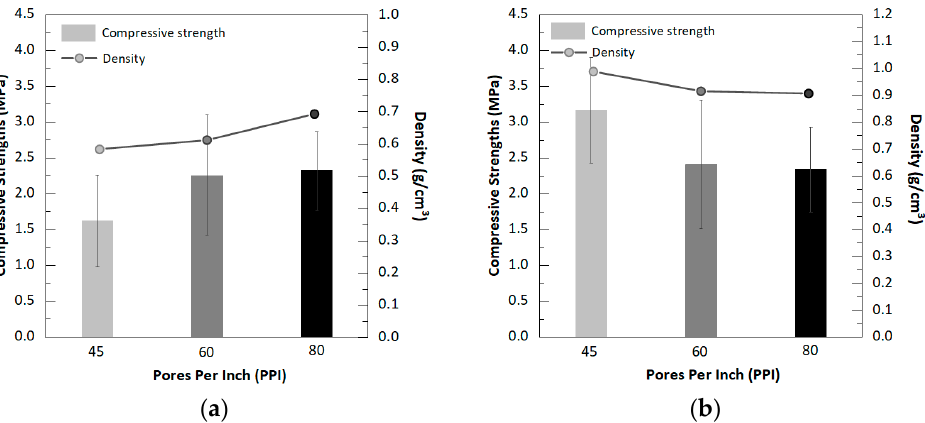
Figure 7. (a) Compressive strengths and densities with pore densities of 45, 60, and 80 PPI with a thickener (using a coarse particle size for the matrix), and (b) compressive strengths and densities with pore densities of 45, 60, and 80 PPI (using a fine particle size for the matrix ). To confirm the effect of the particle size, using coarse alumina as a matrix, zirconia at 40 wt. % and the ZTA slurry with the thickener added were used to control the particle size. The particle size distribution of ZTA according to the ball-milling time is shown in Figure 8a. The particle size is a process variable used to obtain the optimal composition of the reticulated porous ZTA. As the ball-milling time increases, the particle size distribu- tion decreases to 1.360 µm, 1.218 µm, 1.165 µm, and 1.031 µm, relative to the aforemen- tioned particle sizes. Figure 8a shows the viscosities as a function of the shear rate of the ZTA slurries according to the ball-milling time. As the particle size decreases due to ball- milling, the specific surface area increases, and the area where the PVA becomes attached to the particles increases. Accordingly, the viscosity increases as the ball-milling time in- creases. The compressive strength outcomes according to the ball-milling time are shown in Figure 8c. The effect of ball-milling was not visible because the raw particle size was coarse, the densification outcome was poor, and the particle size was not effectively re- duced through ball-milling. Figure 8d shows the density values. Overall, this figure shows a trend similar to that of the compressive strength.